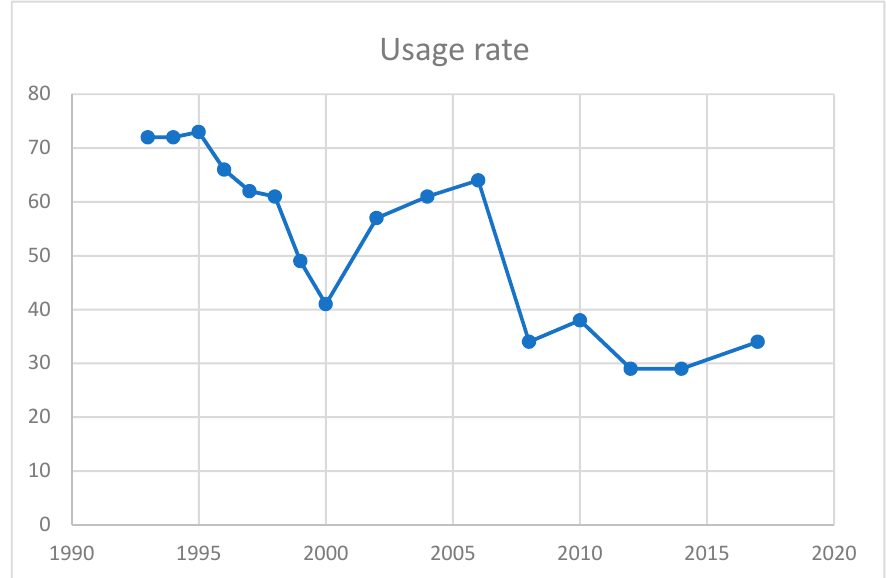
Figure 4. Usage rate (Source: Bain & Company’s surveys 1993–2017).